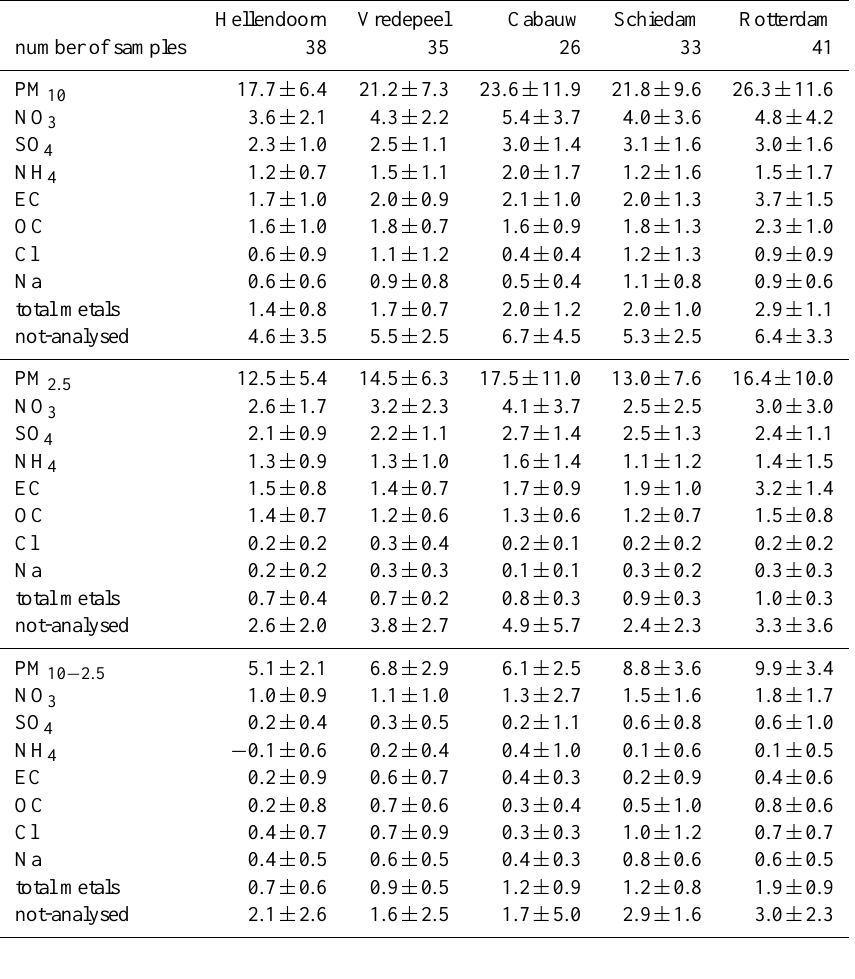
Table 2. Average concentrations (with standard deviations) of the main components as measured at the five BOP-sites.